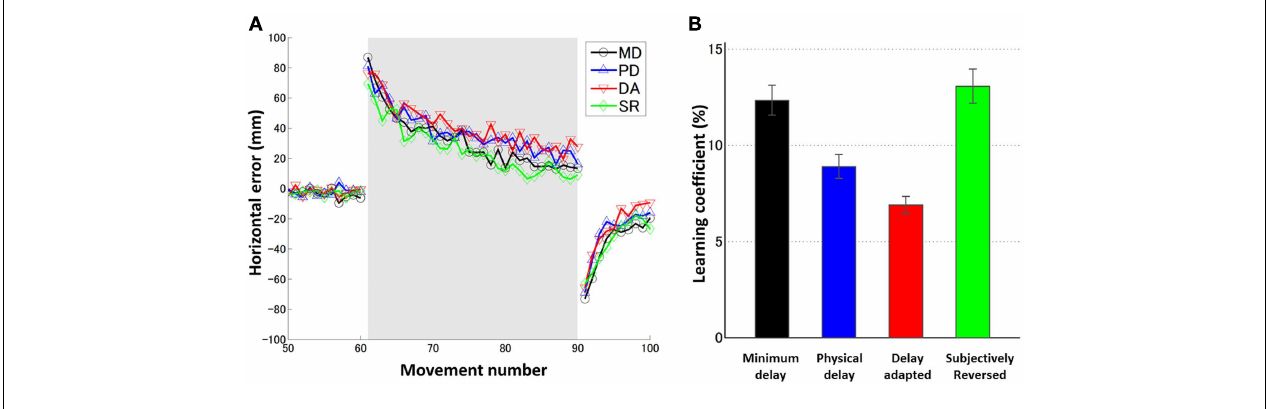
(movements 61–90) indicate the block of prism adaptation. (B) Learning coefficients for six individual subjects for four conditions. Error bars indicate